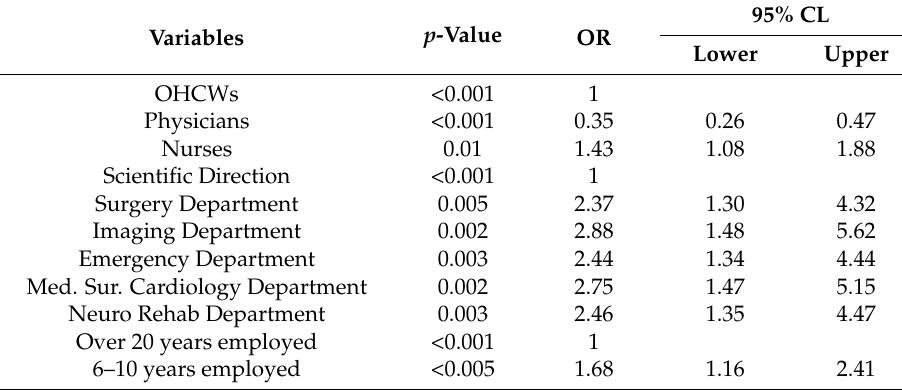
Table 3. Multivariate Logistic